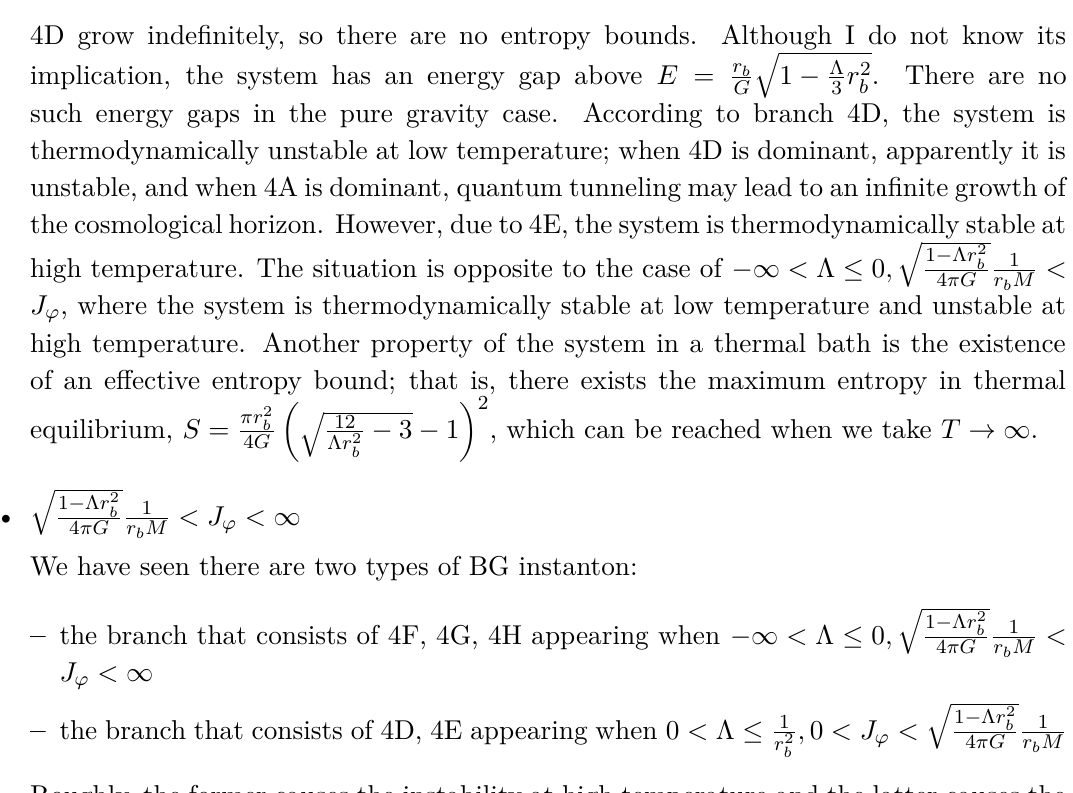
(cid:16)q (cid:17) 2 . 12 − 3 − 1 4 G Λ r 2 b